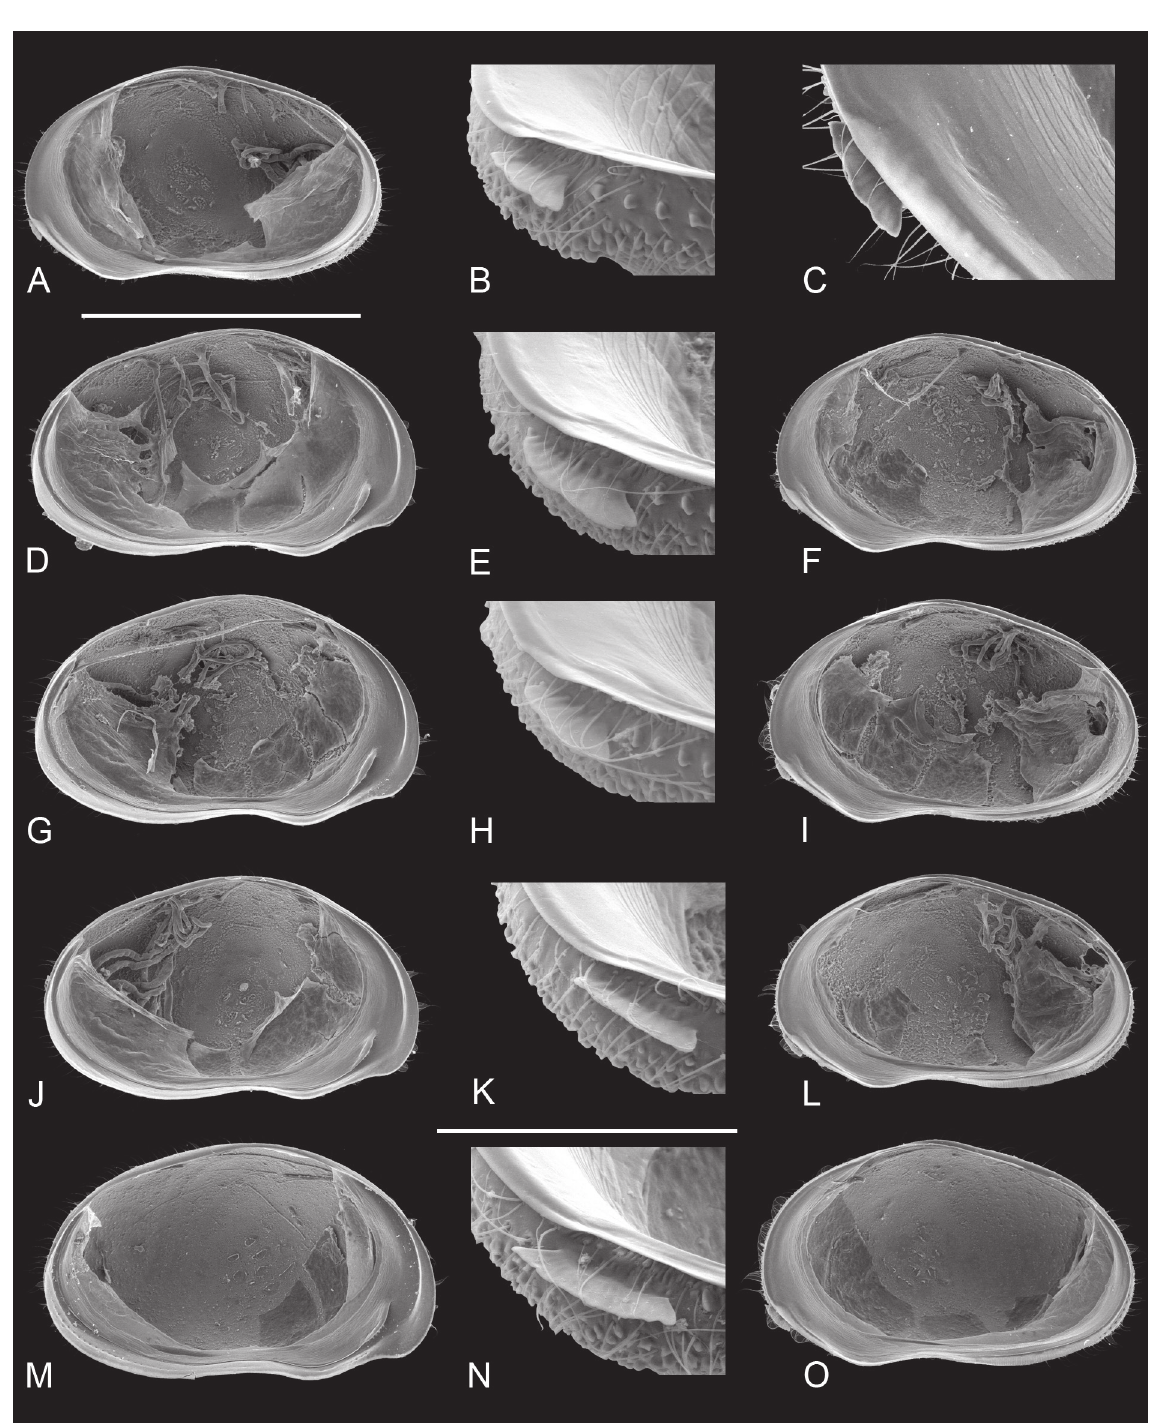
Fig. 5. Bennelongia timmsi sp. nov., all males with hemipenes and prehensiles palps illustrated (see Figs 8-10). a-l = paratypes from Wave rock (BVt/10/05), M-O = non-types from King rocks (BVt/10/06). — A-C . WaMc52232: A . rVi. B . rVi, detail anterior, tilted. C . rVi, detail anterior. — D-F . WaMc52231: D . lVi. E . rVi, detail anterior, tilted. F . rVi. — G-I . Oc.3312: G . lVi. H . rVi, detail anterior, tilted. I . rVi. — J-L . WaMc52230: J . lVi. K . rVi, detail anterior, tilted. L . rVi. — M-O . WaMc52252: M . lVi. N . rVi, detail anterior, tilted. O . rVi. scales: a, D, F-G, I-J, l-M, O = 1 mm; B-c, e, H, K, n = 200